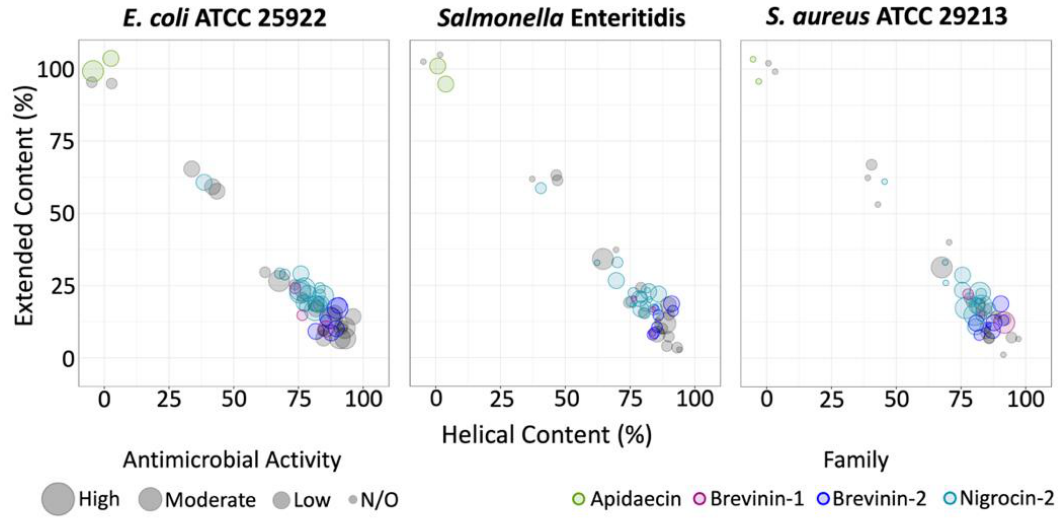
Figure 4. Predicted structural content and antimicrobial activity of 51 bioactive peptides against E. coli , Salmonella Enteritidis, and S. aureus . Secondary structure content indicated by the percentage of residues assigned to participate in helical vs. linear extended regions. Distribution of AMP family members and level of antimicrobial activity are distinguished by colour and size of circles, respec- tively.